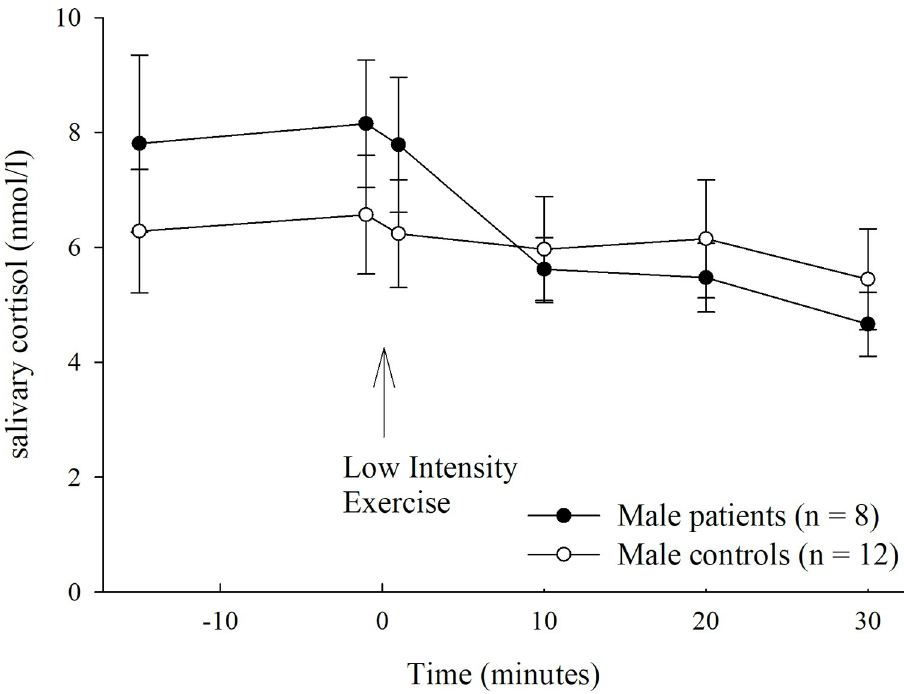
Fig 3. Cortisol response under Low Intensity Exercise (LIE) in male patients with panic disorder and healthy controls. Abbreviations/ see S3 File: LIE, low intensity